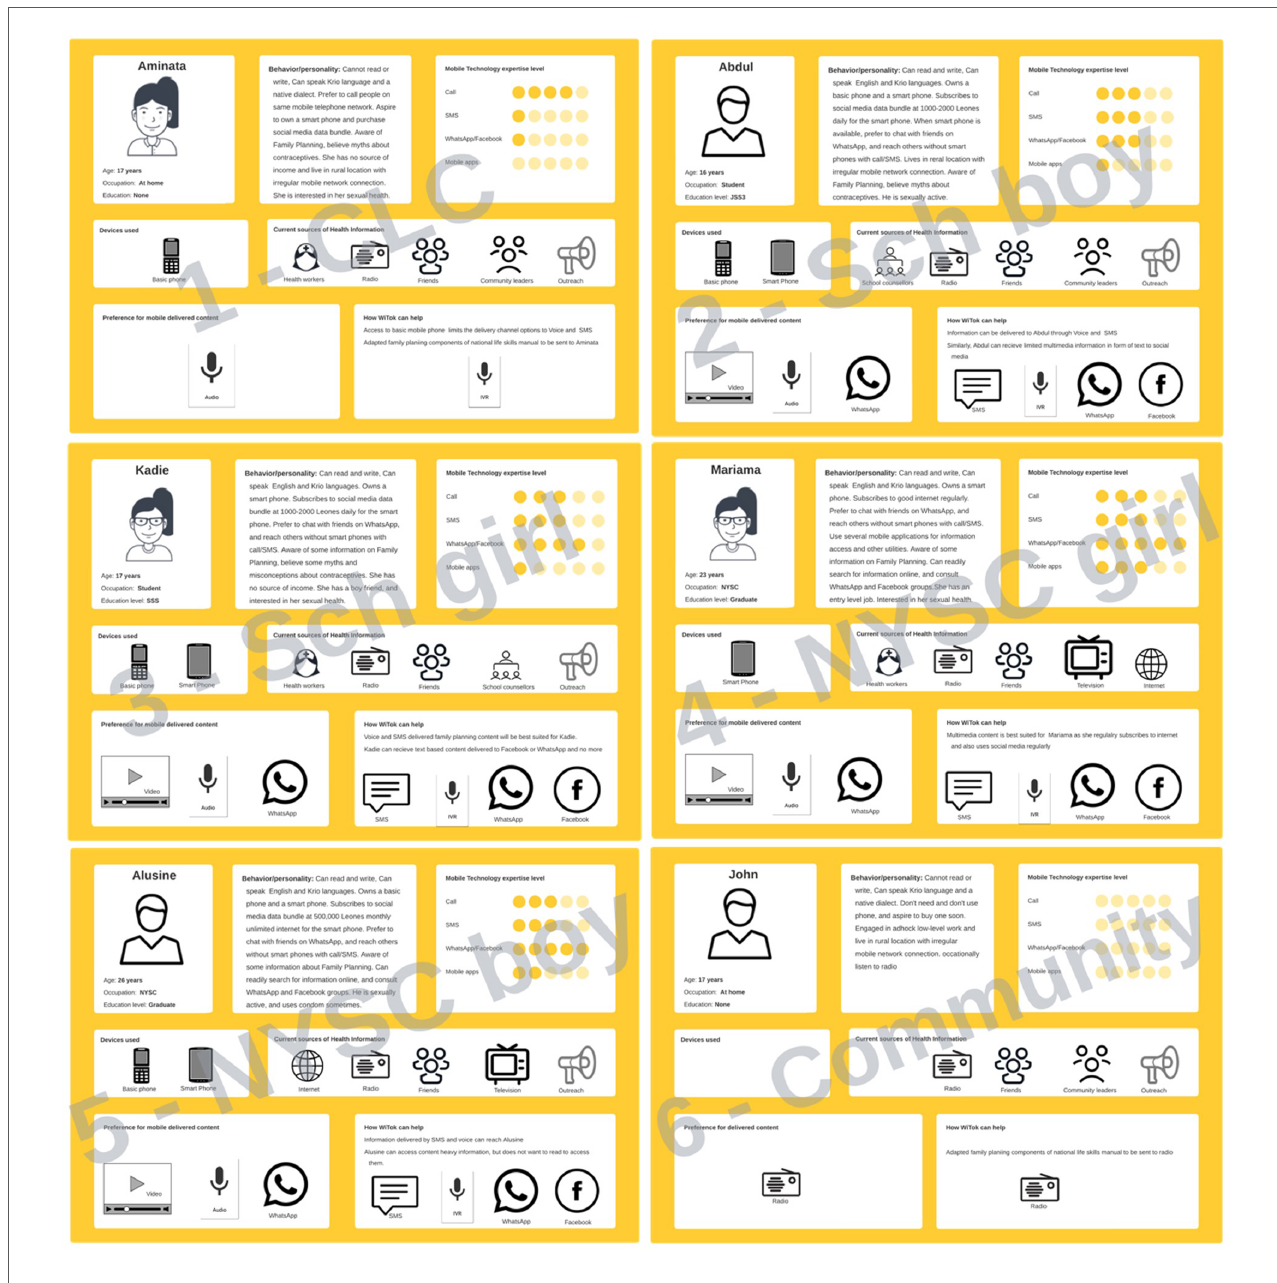
FIGURE 1 Six user personas developed as part of the UNFPA WiTok intervention approach. UNFPA, United Nations Populations